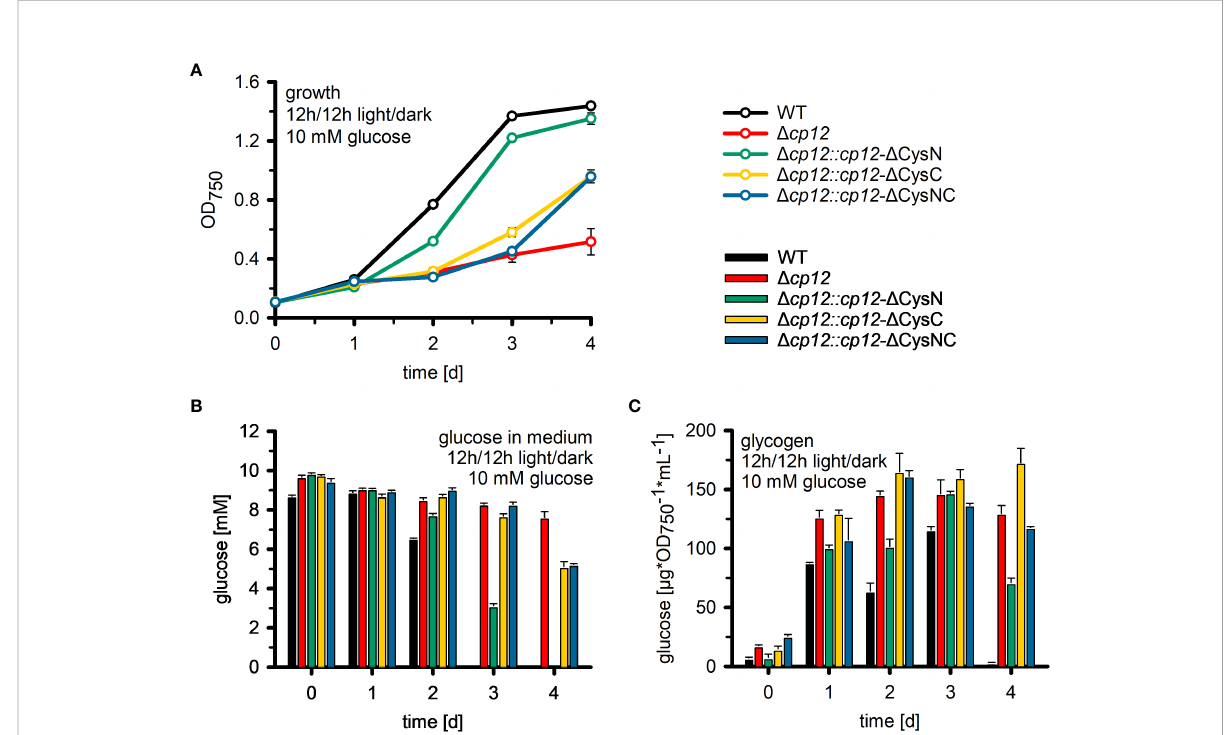
FIGURE 4 Utilization of glucose in mutant D cp12 and strains expressing several CP12 variants. (A) : The growth as an increase in the optical density at 750 nm (OD 750 ) of the Synechocystis sp. PCC 6803 wild type (WT) was compared to mutant strain D cp12 with no CP12, and strains expressing CP12 variants with site-speci fi c mutated Cys pairs, i.e. strains D cp12::cp12 - D CysN, D cp12::cp12 - D CysC, and D cp12::cp12 - D CysNC, under diurnal conditions (12 h light/12 h dark) in the presence of 10 mM glucose. Glucose amounts in the medium (B) and cellular glycogen amounts (C) were quanti fi ed daily. Mean values ± standard deviations from three biological replicates are